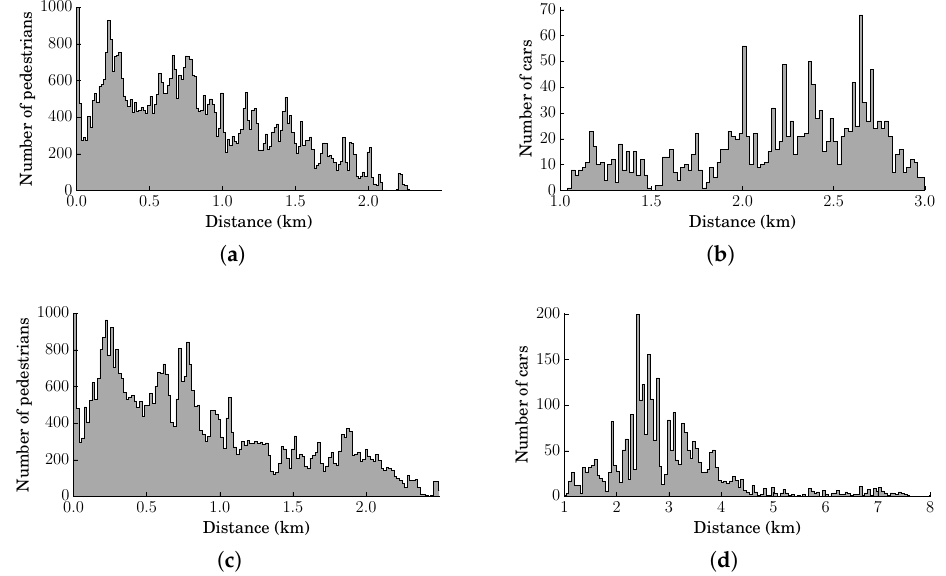
Figure 10. Histograms of the distance to the closest evacuation area for the scenario 3 and 5: ( a ) Pedes- trians (6% car users), ( b ) Cars (6% car users), ( c ) Pedestrians (15% car + route restrictions), ( d ) Cars (15% car users + route restrictions).